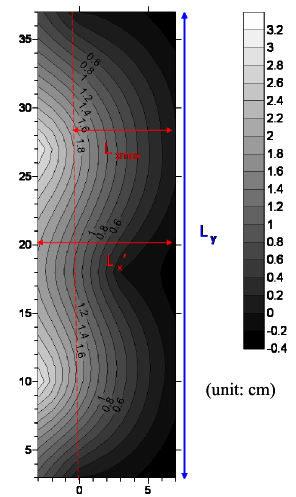
Figure 6. Vertical topographic view of eroded sediment (at 5 min under 25 mm/h rainfall intensity).